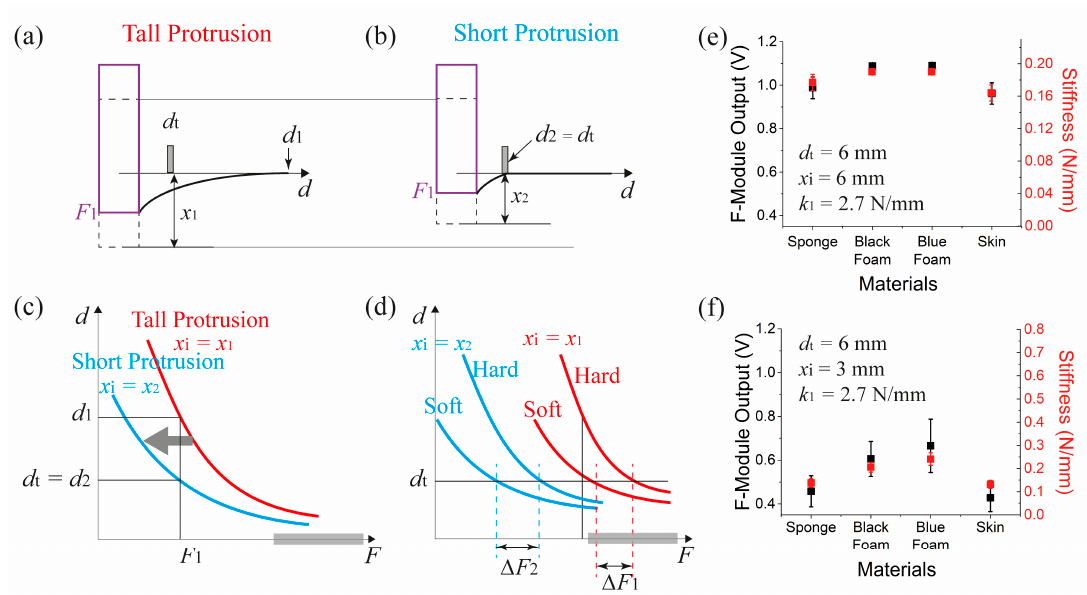
Figure 9. Piston protrusion dependent stiffness measurement. Illustration of the variation of IE of a soft object for ( a ) a tall protrusion and ( b ) a short protrusion. ( c ) Distribution of the IE position depending on applied force. ( d ) Piston protrusion dependent force sensing range selection. Stiffness measurement obtained when the piston protrusion ( xi ) was ( e ) 6 mm and ( f ) 3 mm. For both cases, d t was 6 mm, and k 1 was 2.7 N/mm. (note that ( e ) is the same as Figure 8e).